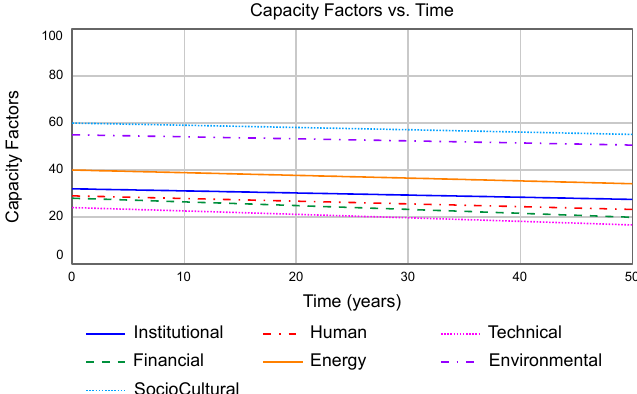
Figure 10. Variation of the seven capacity factors with time assuming capacity dependency and a constraining environment.